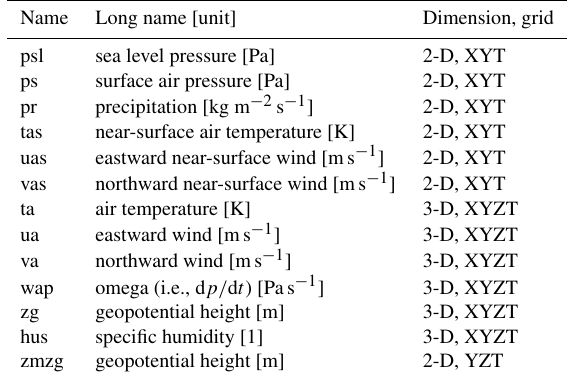
Table 1. Variability. Standard (already in CMIP5) variables at daily and monthly mean frequency. New: more vertical levels (plev19) for 3-D daily and the zonal mean geopotential height,